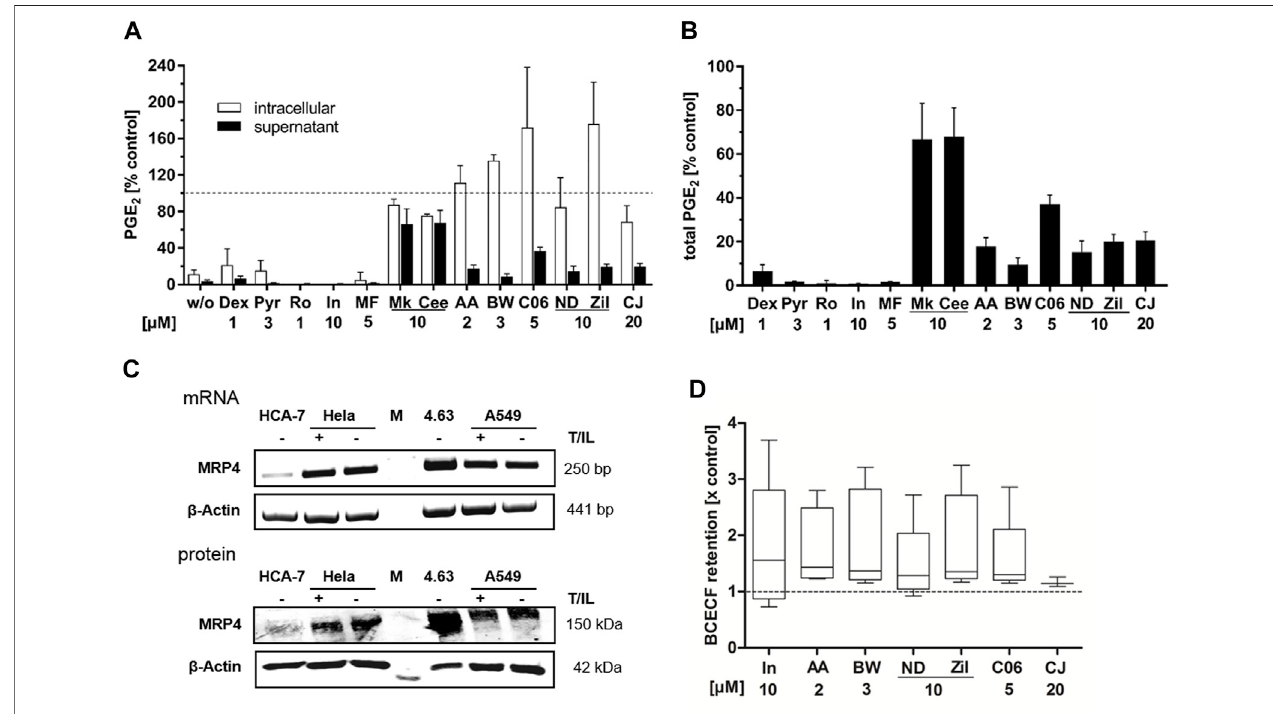
FIGURE 5 | In fl uence on intracellular PGE 2 levels and prostanoid transport. HeLa cells were treated with cytokines (IL-1 β 1 ng mL − 1 , TNF α 5 ng mL − 1 ) and the inhibitors (2 μ M AA-861, 10 µM zileuton, 20 µM CJ-13,610, 3 μ M BWA4C, 10 µM NDGA, 5 µM C06) or vehicle (DMSO) for 5 h. Unstimulated cells served as negative control (w/o). Afterwards, intracellular and extracellular PGE 2 concentrations were assessed separately by LC-MS/MS. The glucocorticoid dexamethasone (1 µM), the COX-2 inhibitor rofecoxib (1 µM), the COX-1/-2/MRP-4 inhibitor indomethacin (10 µM), the cPLA 2 α inhibitor Pyr (3 µM), the mPGES-1 inhibitor MF-63 (5 µM) and the MRP-4 inhibitors Mk-571 and Ceefourin-1 (10 µM each) were used as controls. (A) Intracellular and extracellular PGE 2 levels relative to the vehicle control and (B) (cid:129) total PGE 2 formed relative to the vehicle control. Mean intracellular PGE 2 formation was 0.82 ± 0.50 ng mio − 1 cells and extracellular 18.24 ± 4.74 ng mL − 1 . Values representmean+SDofthreeindependentexperiments. (C) mRNAandproteinexpression ofMRP-4inHeLa,A549,HCA-7 andHek293/4.63cells. (D) In fl